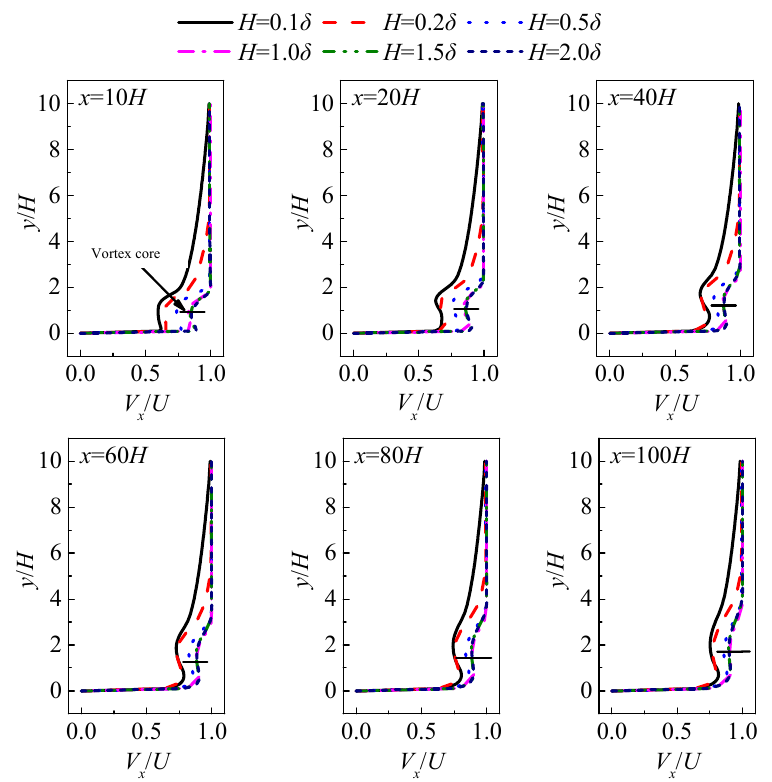
Figure 17. Velocity profiles at the vortex core downstream of the VG.